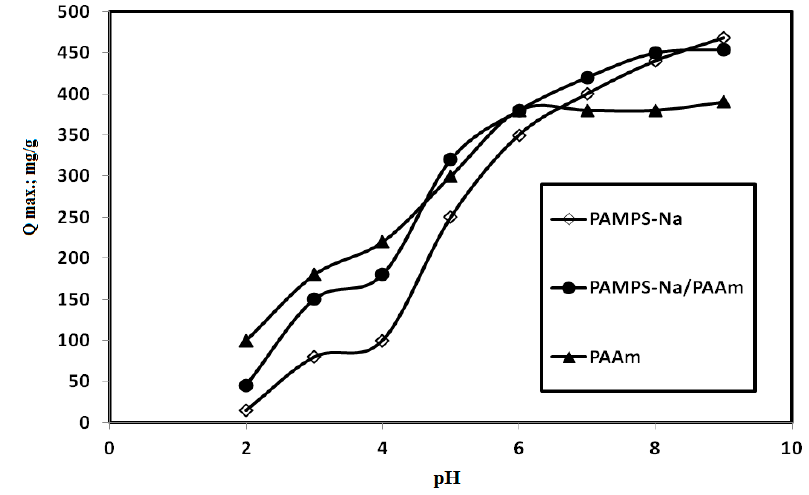
Figure 5. Relation between adsorption capacities of silica-nanogel composites for 1000 ppm of methylene blue (MB) and their pH of solutions at constant ionic strength, 1 M.